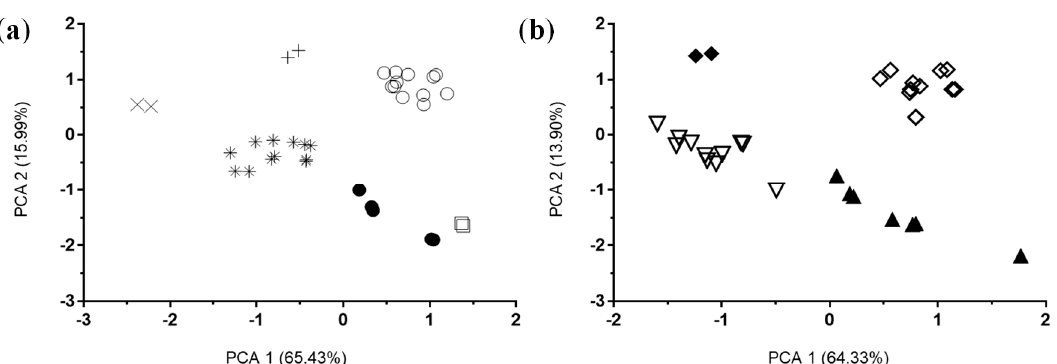
Figure 2. Principal component analysis of all the relevant molecular descriptors generated for the 67 molecules (PVLs and PVAs). ( a ) PCA for PVLs. Black circles: unconjugated PVLs; asterisk: PVL-sulfate conjugates (including methoxy-sulfate ones); white circles: PVL-glucuronide conjugates (including methoxy-glucuronide ones); cross: PVL-sulfate-glucuronide conjugates; oblique cross: PVL-disulfate conjugates; white squares: PVL-methoxy conjugates (not presenting sulfate or glucuronide moieties). ( b ) PCA for PVAs. Black triangles: unconjugated PVAs; white triangles: PVA-sulfate conjugates (including methoxy-sulfate ones); white rhombus: PVA-glucuronide conjugates (including methoxy-glucuronide ones); black rhombus: PVA-sulfate-glucuronide conjugates.